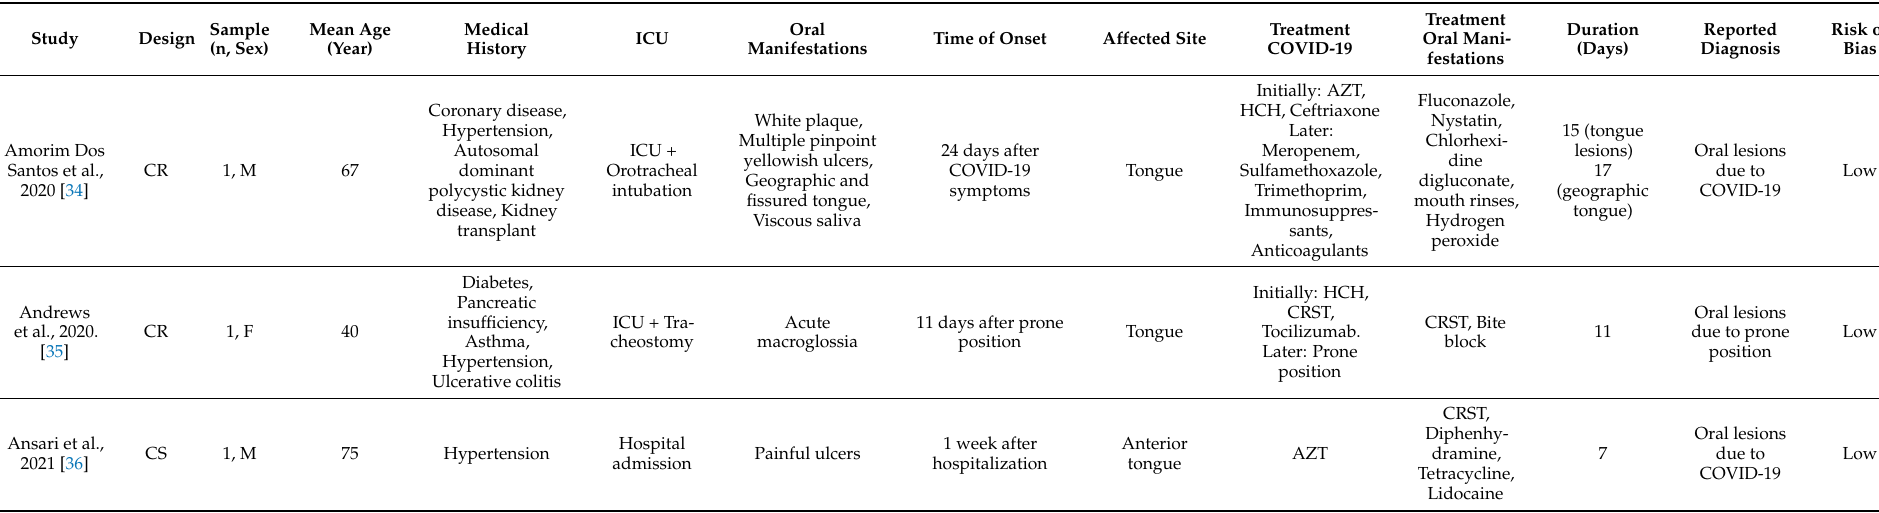
Table 2. Descriptive characteristics of included studies regarding oral lesions that appeared during hospitalization in patients affected by COVID-19. F: female; M: male; CS: cases series; RS: retrospective study; CSS: cross-sectional study; CR: case report; OS: observational study; NA: not available; AZT: azithromycin; CRST: corticosteroids; IVIG: